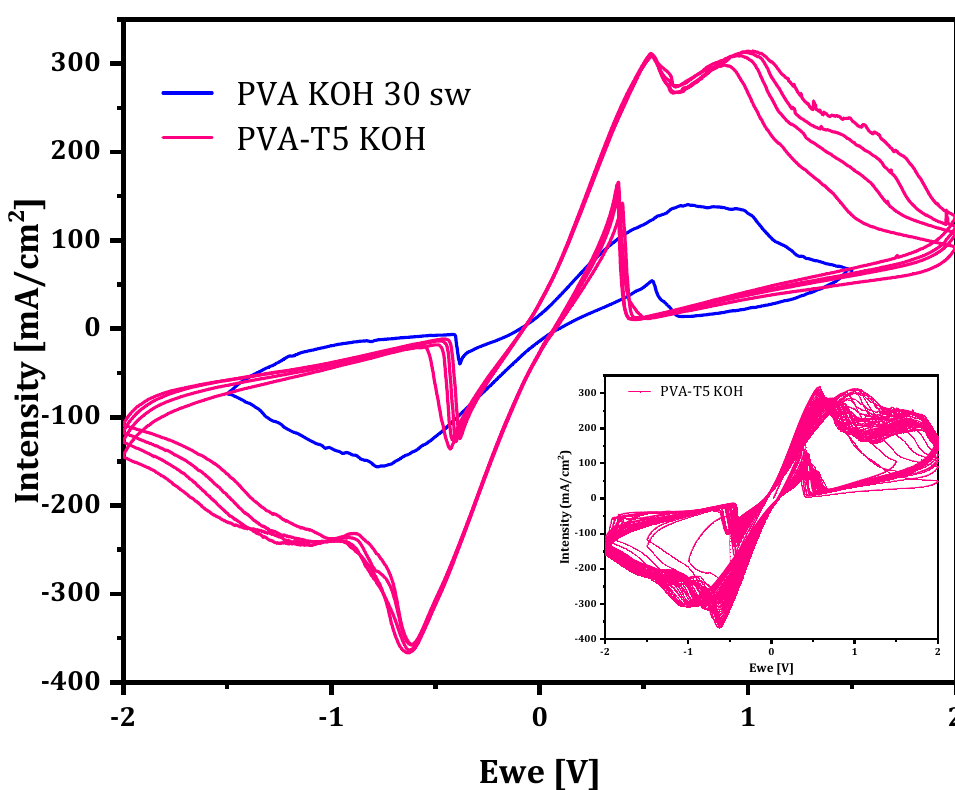
Figure 10. Cyclic voltammograms of the PVA-T4 KOH and PVA-KOH 30 swollen membranes [4]. Inset: 30 consecutive cycles of the PVA-T4 KOH film. Inset: 30 consecutive cycles of the PVA-T4 KOH